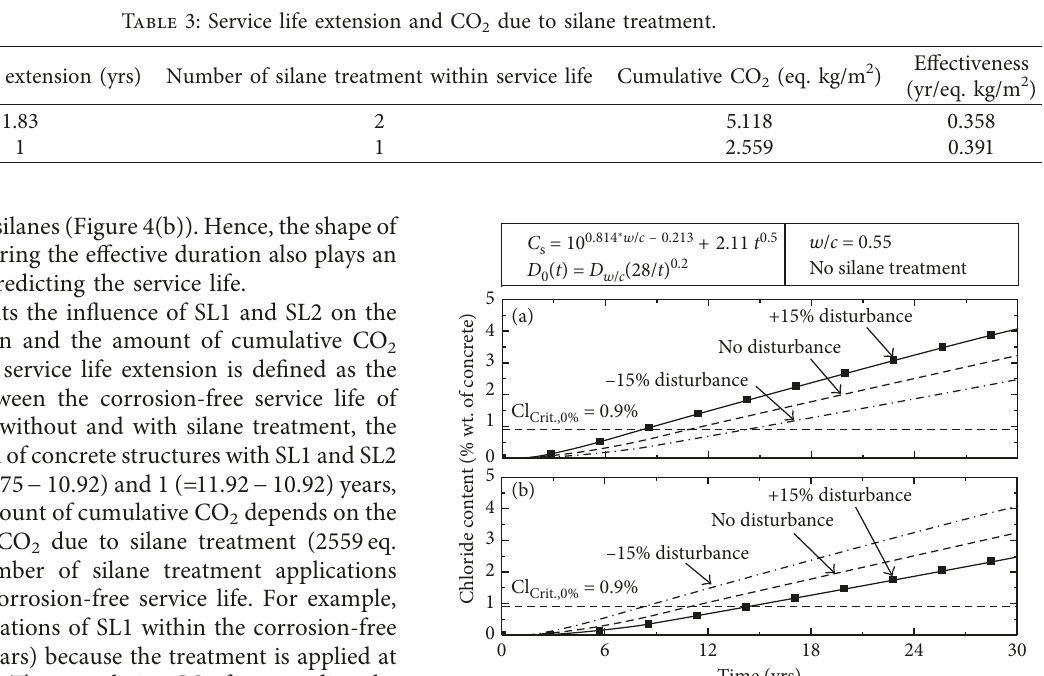
2 due to silane treatment.